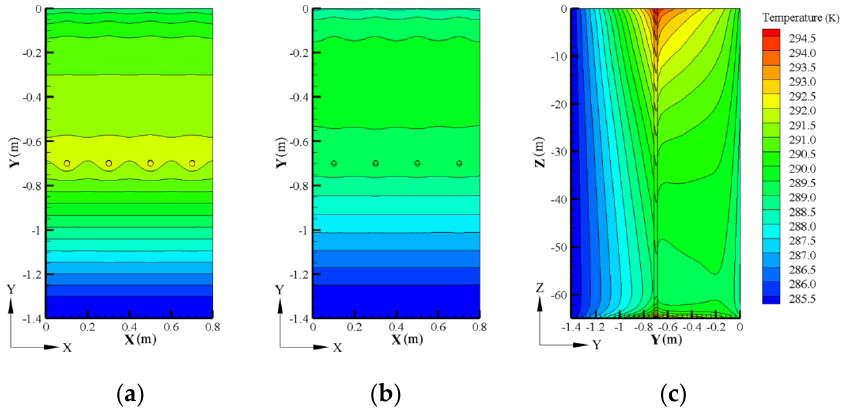
Figure 20. Soil temperature distribution at 4:00 on Dec. 27, 2019. ( a ) Z = − 15 m, ( b ) Z = − 50 m, and ( c ) X = 0.3 m (the X-to-Y ratio is set as